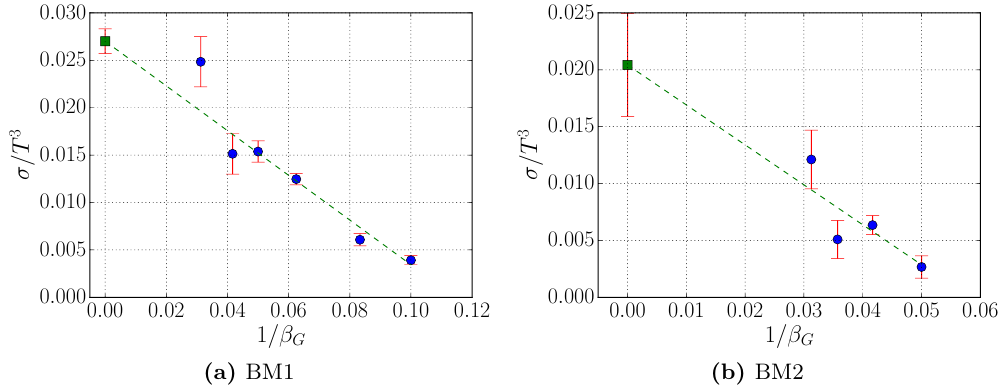
Figure 9. Continuum extrapolation of the interface